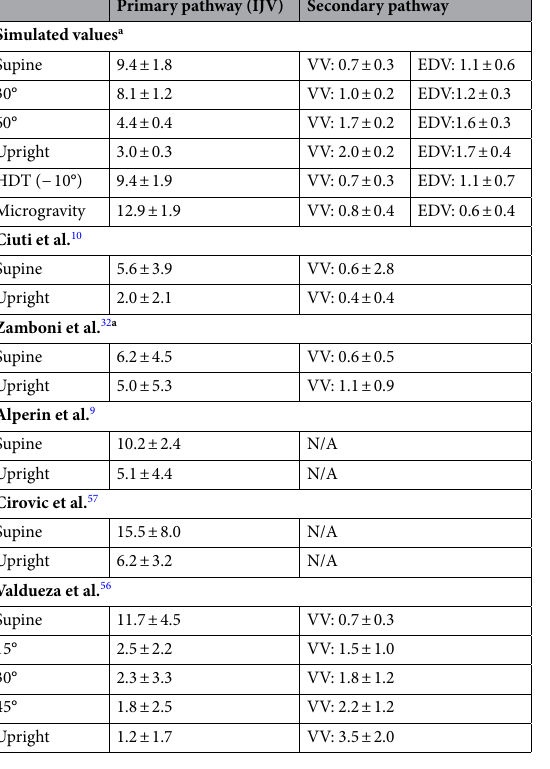
Table 2. Simulated mean flows and literature flow values (mean ± standard deviation) considered in this study. All values are reported in ml/s. IJV internal jugular vein, VV vertebral vein, EDV epidural vein (summation of VV and DCV), HDT head-down tilt. a The IJV flow is the average value of the three segments (J1, J2, and